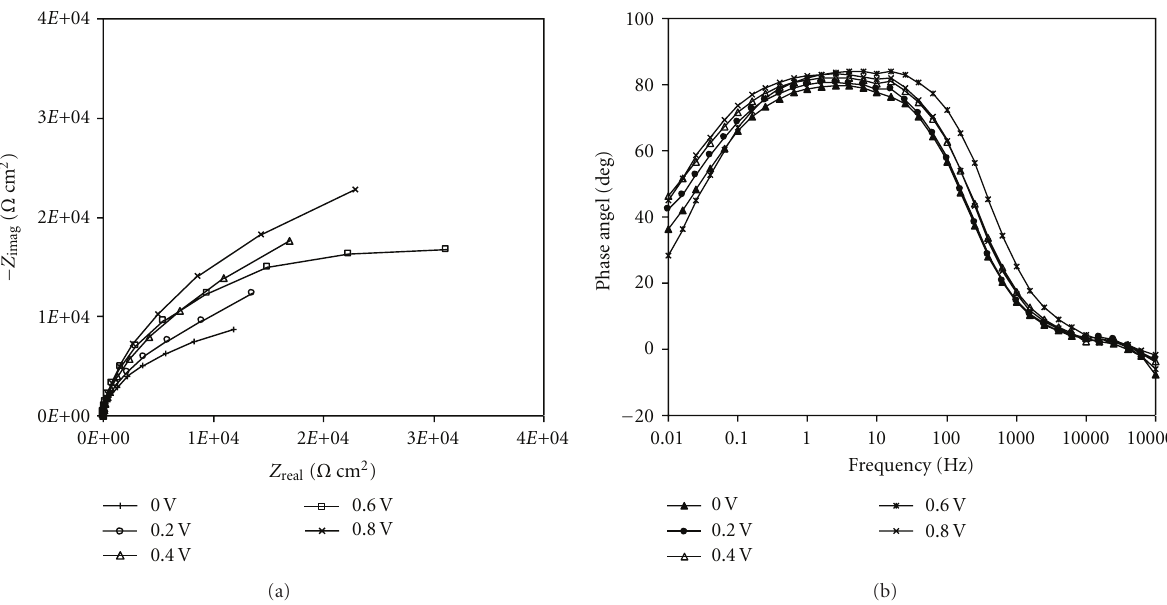
Figure 3: Impedance spectra for AISI 321 stainless steel in 0.5MH 2 SO 4 solution as a function of film formation potential: (a) Nyquist plots and (b) Bode plots.